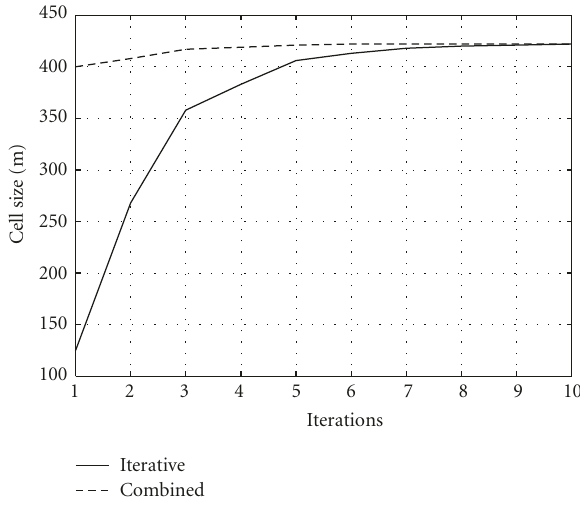
Figure 6: Number of iterations to convergence for the iterative and combined heuristics (experiment